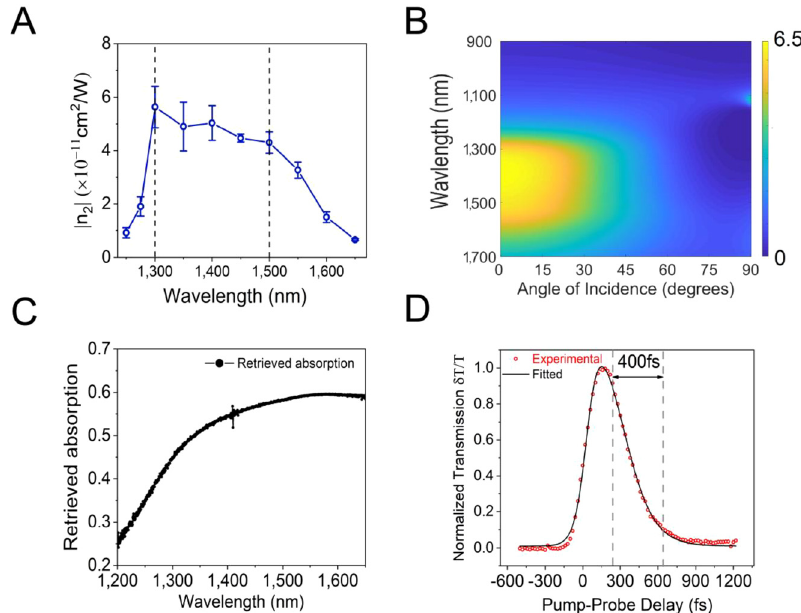
Figure 3: Nonlinear properties of the designed ENZ